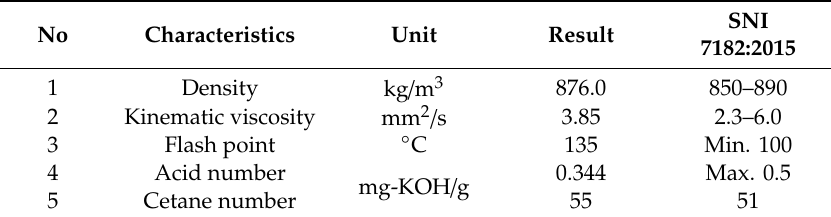
Table 4. Characteristics of the obtained biodiesel.